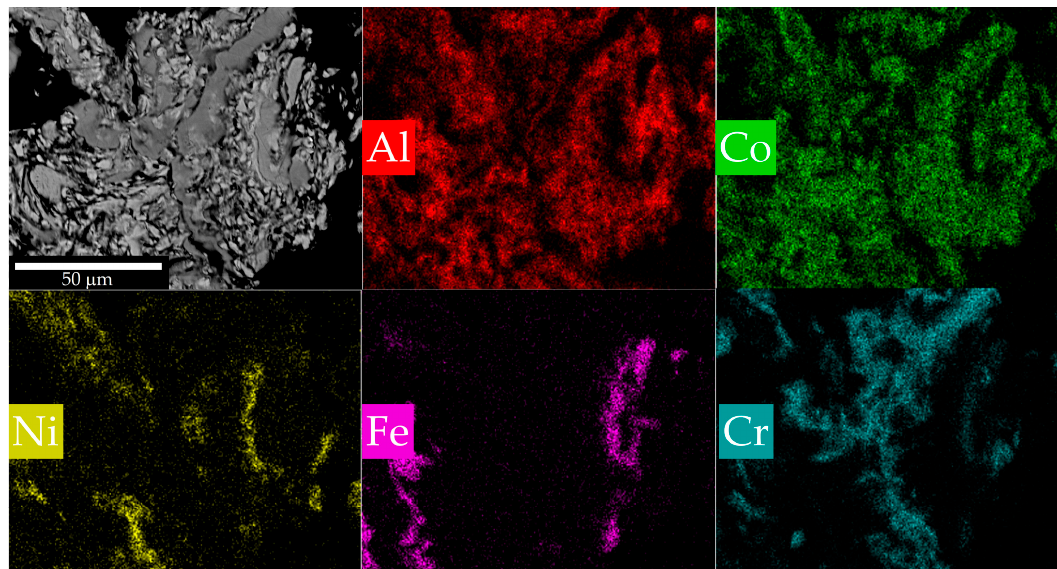
Figure 2. Cross-section and EDS element map of the powder after MA.